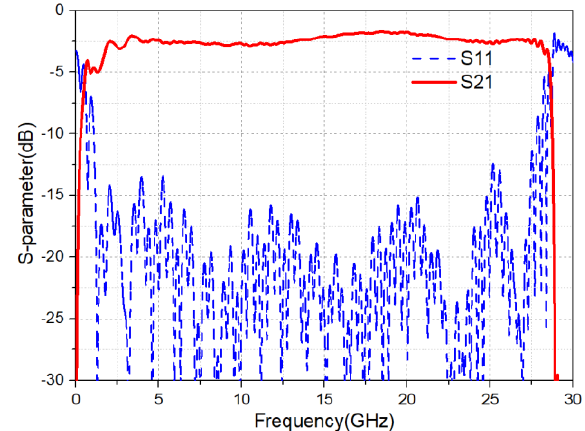
Figure 4. The simulated S-parameter of SSPP TL.